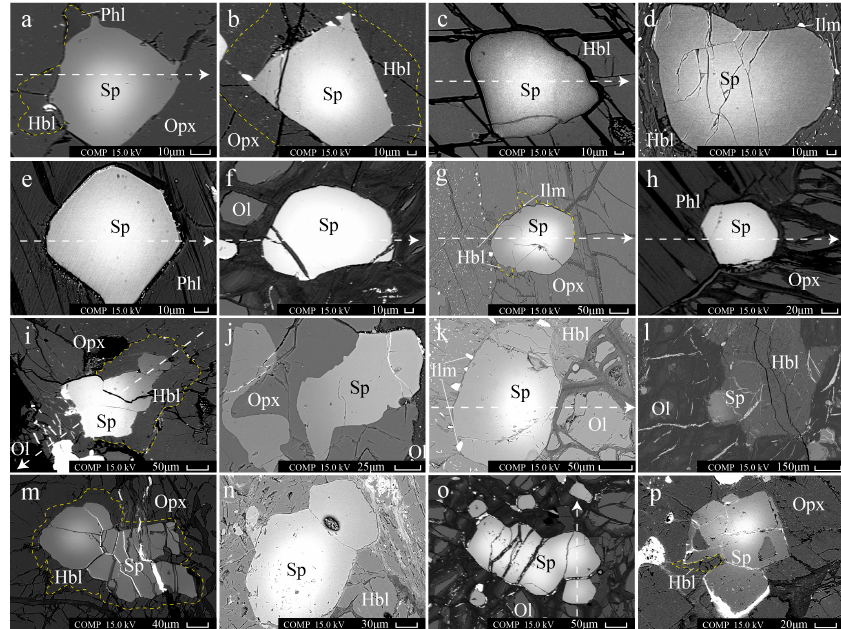
Fig.3 Figure 3. Back-scattered electron images of Cr-spinel (Sp), and the arrows denote the trend of compositional profiles: ( a , b ) Zoned Cr-spinel surrounded by enstatite (Opx) along with tschermakite (Hbl) and phlogopite (Phl); ( c , d ) Zoned Cr-spinel surrounded by tschermakite carrying ilmenite (Ilm), showing the seeming disconnection between the reverse zonation and the crack in Cr-spinel; ( e ) Zoned Cr-spinel surrounded by phlogopite; ( f ) Zoned Cr-spinel surrounded by olivine; ( g ) Interstitial zoned Cr-spinel located between tschermakite and enstatite; ( h ) Interstitial zoned Cr-spinel located between phlogopite and enstatite; ( i , j ) Interstitial asymmetrically-zoned Cr-spinel located between olivine and enstatite; ( k , l ) Interstitial asymmetrically-zoned Cr-spinel located between olivine and tschermakite; ( m – p ) Cr-spinel cluster enclosed in enstatite, tschermakite, and olivine, with only relatively large Cr-spinel grains showing